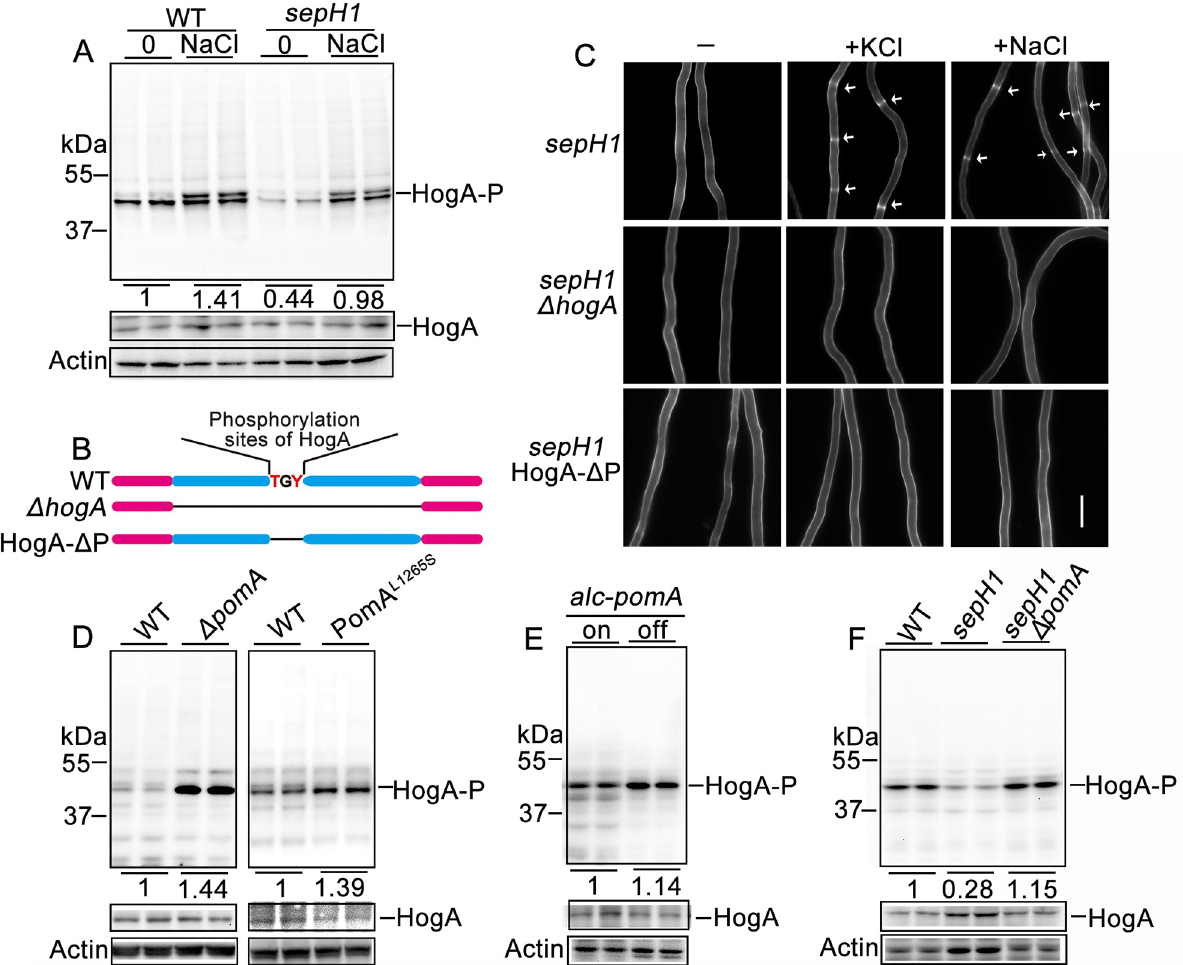
Fig 5. PomA and SepH reversely affected the phosphorylation of HogA. (A) The phosphorylation level of wild type (TN02A7) and sepH1 strains cultured in liquid minimal media PGRUU treated with or without 1 M NaCl for 10 min at 42 ˚C for 24 h. (B) Diagram showing strategies of HogA full-length deletion and deleted for predicted phosphorylation sites (171–173) of HogA. (C) Comparison of hyphal cells stained with CFW for the sepH1 , sepH1 Δ hogA and sepH1 HogA- Δ P with or without treatment of 1 M NaCl or 1 M KCl at 42 ˚C. Arrows indicate the locations of septa. Bars, 10 μ m. (D) Western blot analysis showing the expression level of P-HogA in the pomA null mutant and the pomA site-directed strain cultured in liquid minimal media PGRUU at 37 ˚C or (F) sepH1 relative strains at 42 ˚C for 24 h. (E) Western blot analysis showing the expression level of P-HogA in the alc(p) ::GFP- pomA strain cultured in de-repressed media MMPGR at 37 ˚C for 24 h or transferred to repressed media YAG for 30